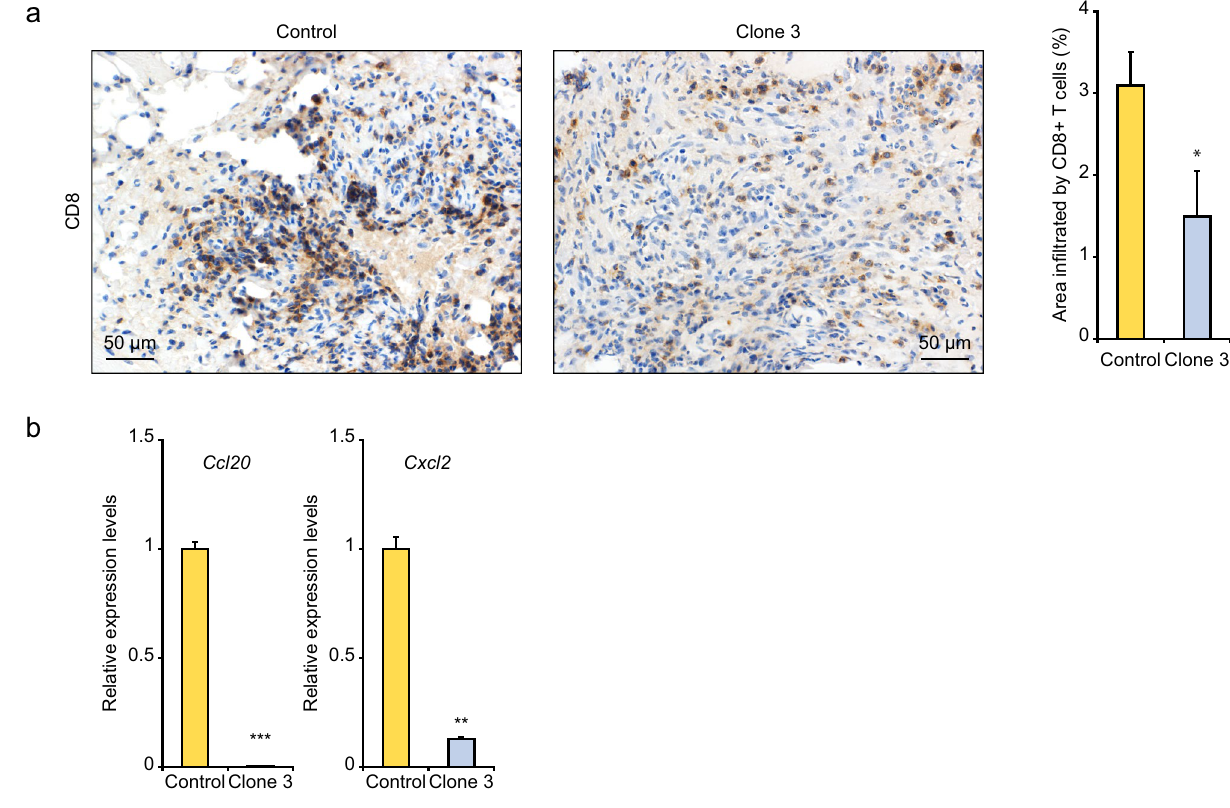
Figure 7. Immune evasion of mouse HCC tissues with β-catenin signaling activation. ( a ) CD8+ T cells in grafted tumor tissues. The left and right panels show representative immunohistochemical images and T cell infiltration data, respectively. ( b ) Quantitative PCR analysis of cytokine genes in grafted tumor tissues. Error bars are the mean ± SD. P -values were calculated by Welch’s t test. * P <